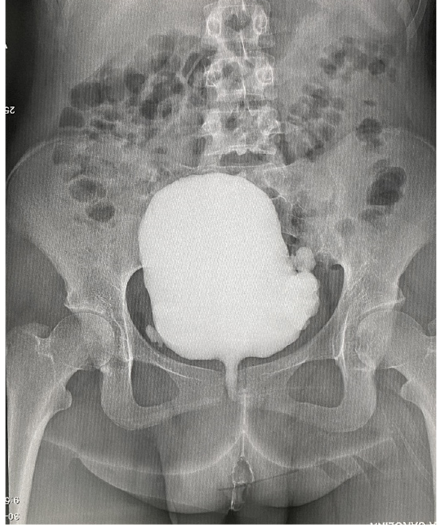
Figure 5. Micturition urethrocystography showing vesical diverticula.